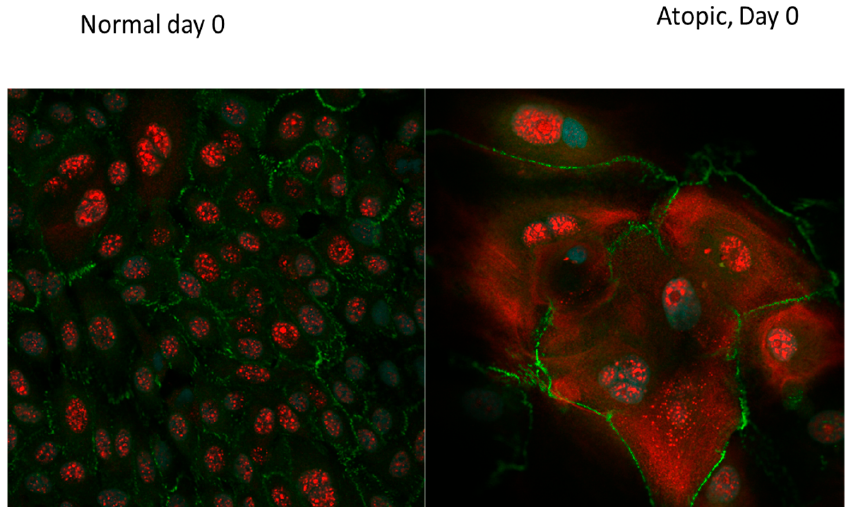
Figure 11. Confocal microscopy images of normal and atopic keratinocytes at the first day of confluence (D0). Confocal microscopy was performed on Nikon A1RMPsi-STORM4.0 on the 60 X water objective. On the left, keratinocytes harvested from a normal dog while on the right, keratinocytes harvested from an atopic dog. On D0, atopic keratinocytes appeared larger, more differentiated and with more variation in size compared to the normal keratinocytes which appeared smaller and more uniform in size. Filaggrin (stained in red) was evident only in the nucleus in the normal keratinocytes, while in the atopic keratinocytes, it was present both in the nucleus and in the cytoplasm. This distribution was consistent with a further stage of differentiation. ZO-1 (stained in green) was evident on the membrane of the keratinocytes in both normal and atopic keratinocytes. Light blue was DAPI, a fluorescent DNA stain, to locate the nucleus of the